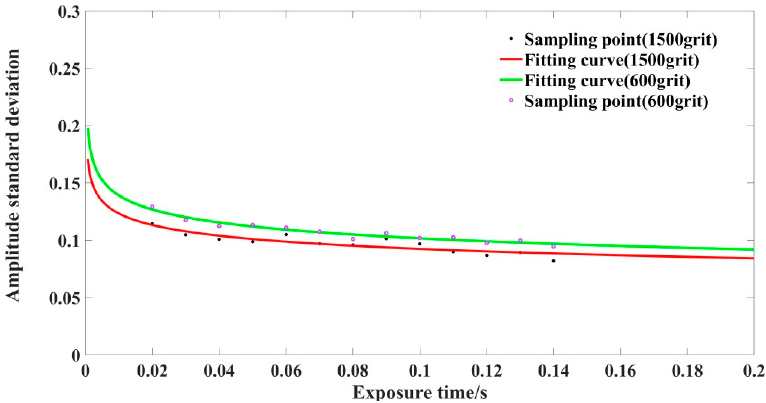
Figure 7. Comparison of fitted curves of amplitude standard deviation for 600 grit and 1500 grit diffusers in doubly scattered system.